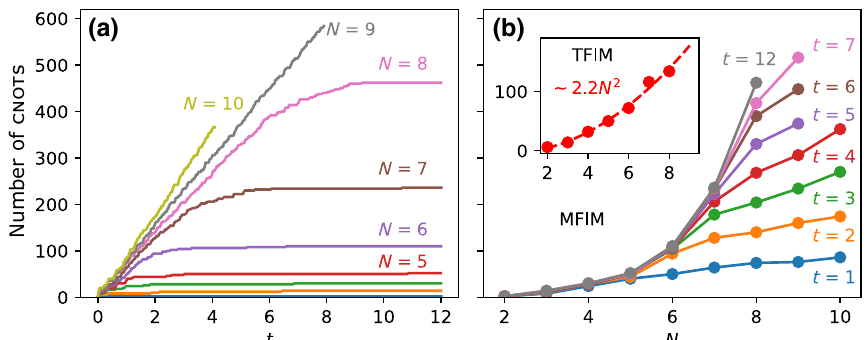
FIG. 7. Number of CNOT s N cx in the AVQDS circuits for the MFIM as a function of simulation time t and system size N . (a) The AVQDS circuit depth for MFIM initially grows linearly with t , followed by a slowdown toward saturation. Times up to t = 12 are considered for N ≤ 8, with shorter final times shown for N = 9, 10. Clearly for N ≤ 8, the circuit begins to saturate at a critical time t s < 12. (b) Vertical cuts of (a) at constant times for 1 ≤ t ≤ 7 and t = 12. Inset: quadratic scaling of the saturated N cx for AVQDS simulations of the integrable